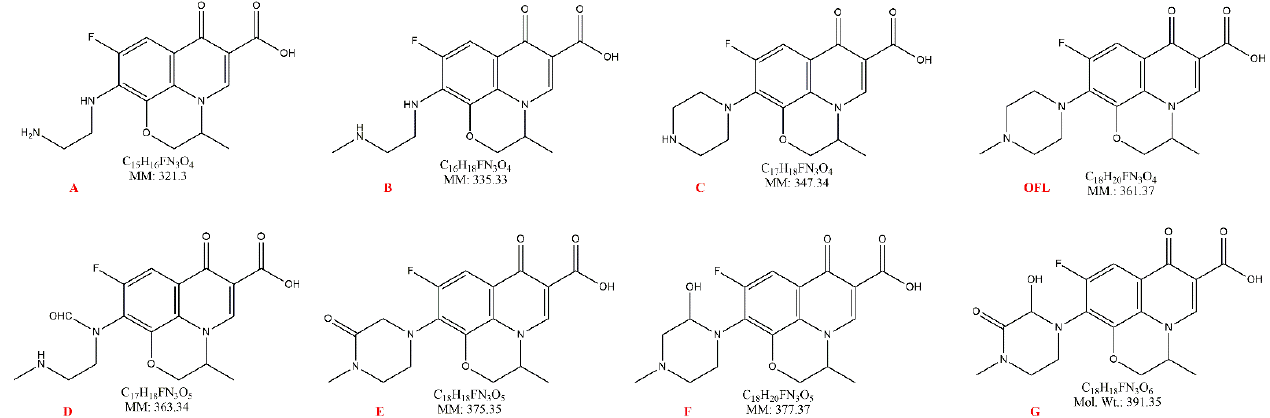
Figure 5. Identified OFL photoproducts reported in the literature.